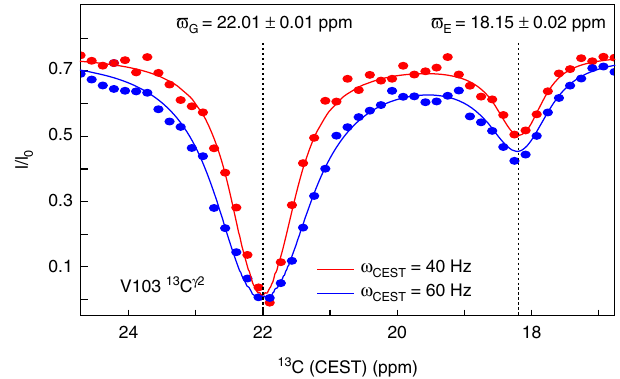
Fig. 4 Quantifying side-chain motions on the millisecond timescale. CEST pro fi les to quantify millisecond chemical exchange of V103 13 C γ 2 in T4L L99A at 278 K are shown. The circles represent experimentally obtained normalised intensities, and the lines are the result of a least-squares fi t. Uncertainties in the reported ϖ G and ϖ E are obtained using the covariance method in the least-squares fi t (see Materials and Methods for full details)